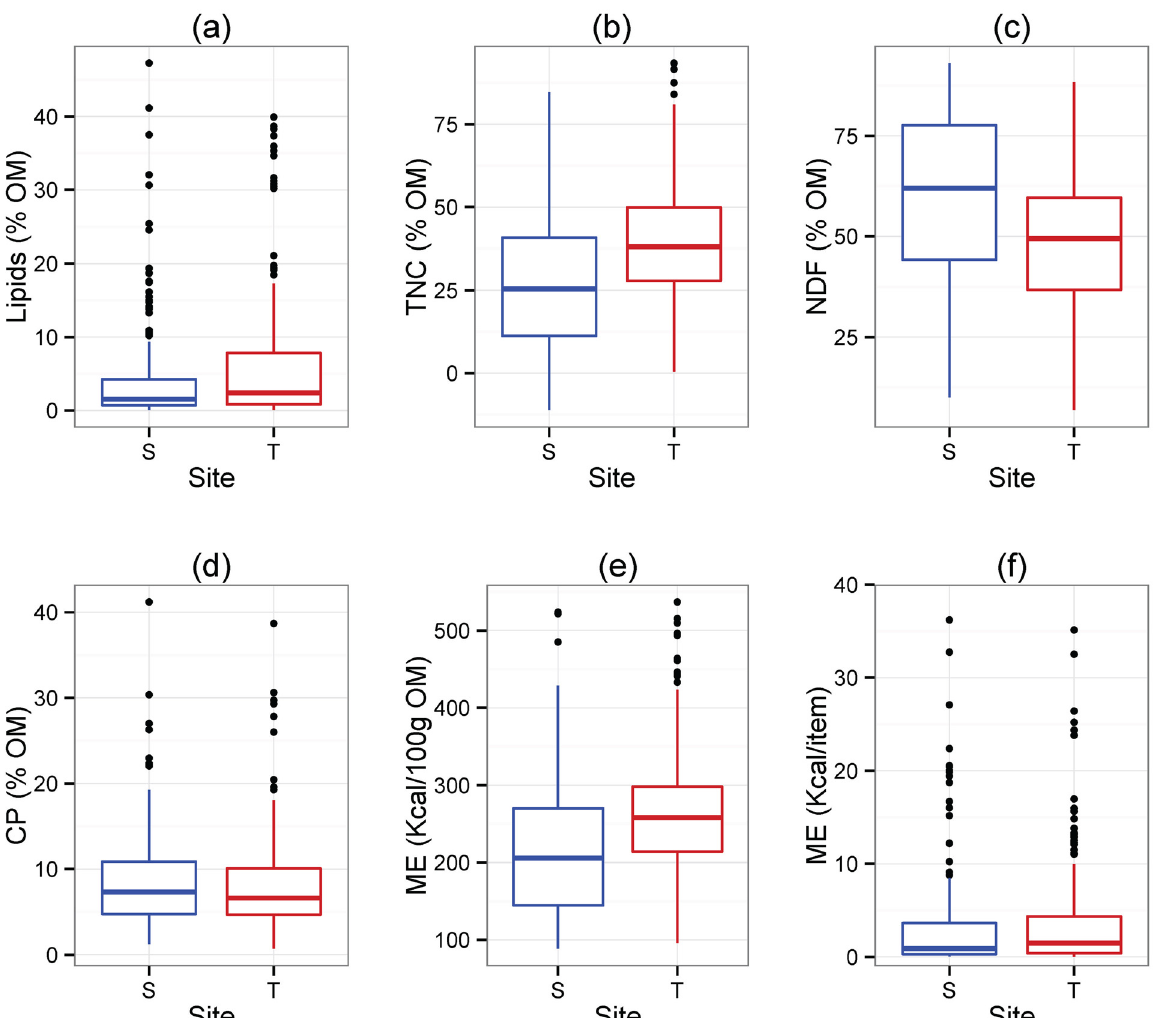
Fig 1. Variation in macronutrient composition in the orangutan diets in Tuanan (T) and Sabangau (S). All comparisons are based on organic matter (OM) and Wilcoxon Signed Rank Test were used. A significant negative Z-statistic indicates Tuanan is greater. (a) Lipids (Z = -2.17, p = 0.03); (b) Total non- structural carbohydrates (TNC; Z = -5.43, p < 0.0001); (c) Neutral detergent fiber (NDF; Z = 5.63, p < 0.0001); (d) Crude protein (CP; Z = 0.64, p = 0.52); (e) Metabolizable energy (Kcal/100 g OM) (Z = -5.55, p < 0.0001); (f) Metabolizable energy/item (Kcal)(Z = -2.64, p = 0.008). See Table 1 for complete statistical